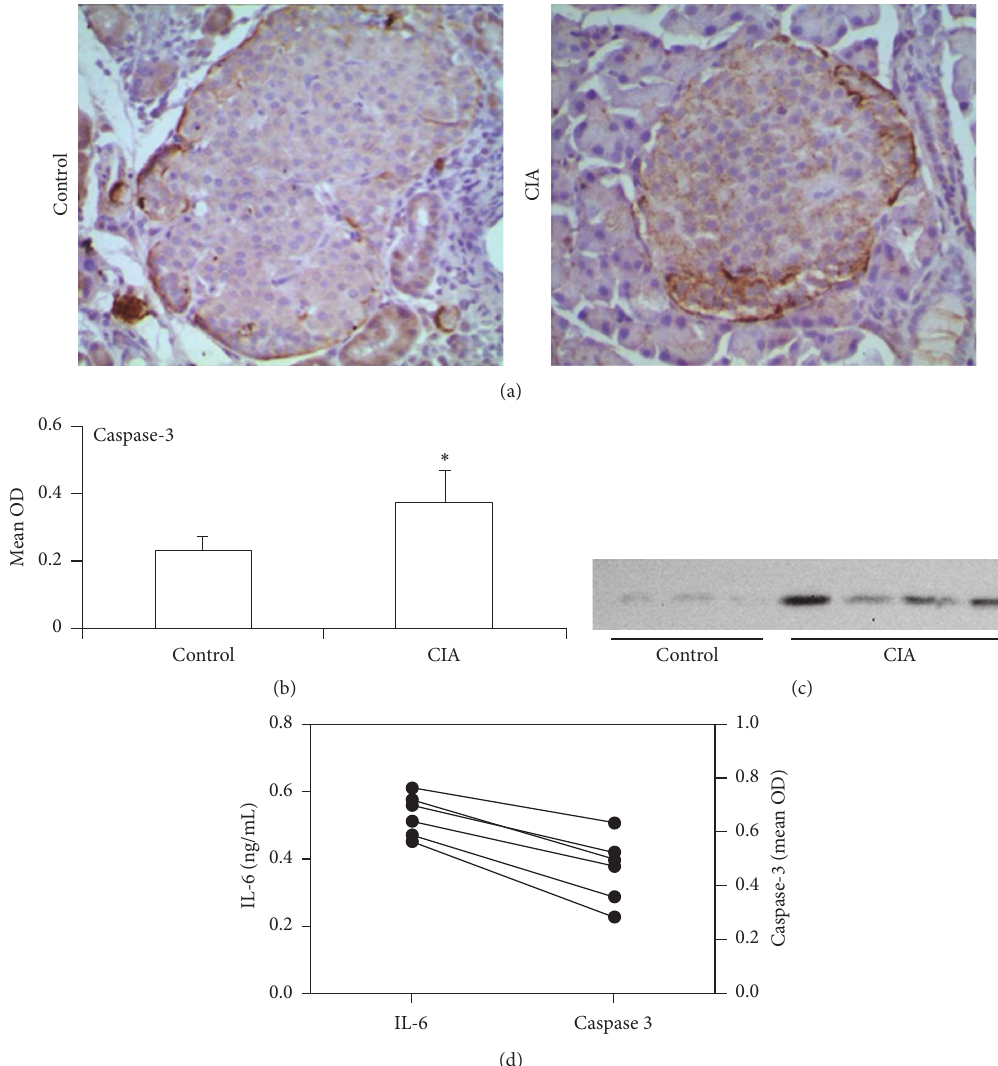
Figure 5: Potential of IL-6 in the apoptosis of 𝛽 -cells. The pancreas islets were harvested after day 17 of immunization. (a) The apoptosis related gene caspase-3 was analyzed by immunohistochemistry. (b) The expression of caspase-3 was analyzed by OD value. Image-Pro Plus 6.0 was used to delineate the scope of each field in the islets and measure the mean absorbance of the islets. (c) The proteins of pancreas islets were extracted for analyzing cleaved caspase-3 expression by immunoblots assays. Data are representative of three independent experiments (d) Paired Student’s 𝑡 -test was used for analyzing the paired data of IL-6 and caspase-3. Data are shown as the mean ± SD ( 𝑛 = 6 – 8 /group) and are representative of three independent experiments. ∗ 𝑝 < 0.05